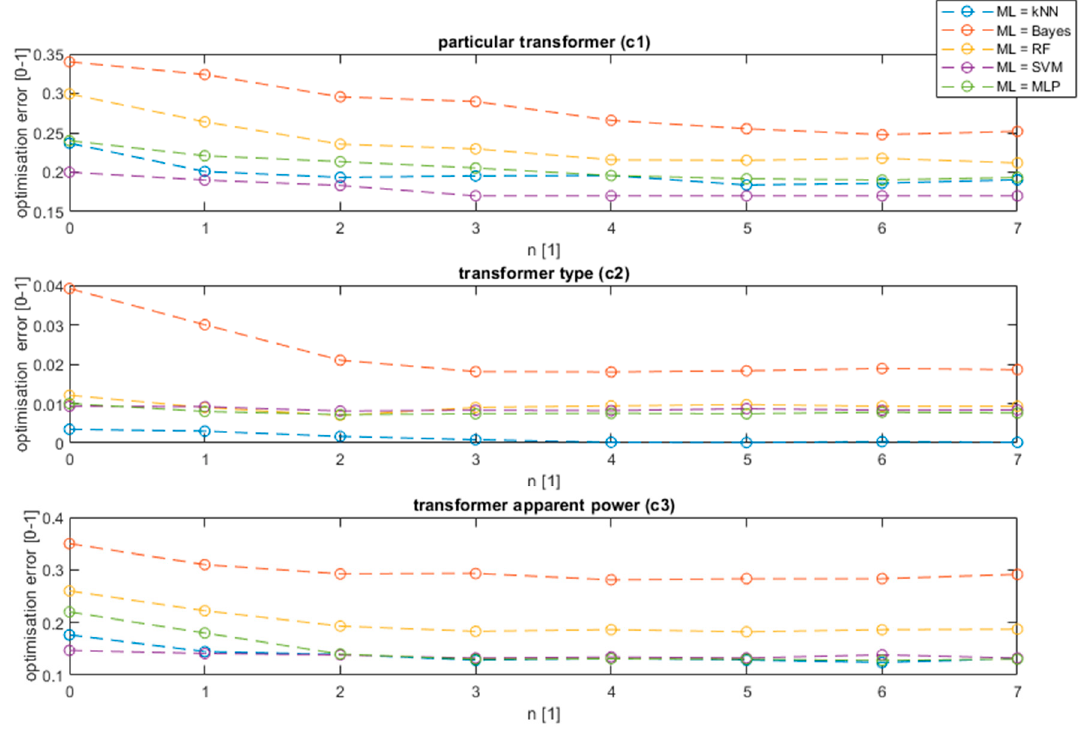
Figure 9. Training for all ML algorithms and analyzed features.